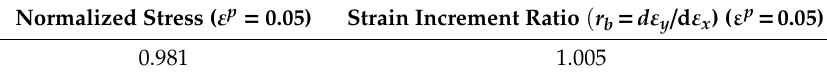
Table 2. Equi-biaxial stress and strain